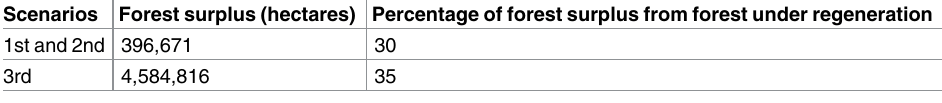
Table 4. Proportion of forest regeneration in forest surplus for CRA scenarios.